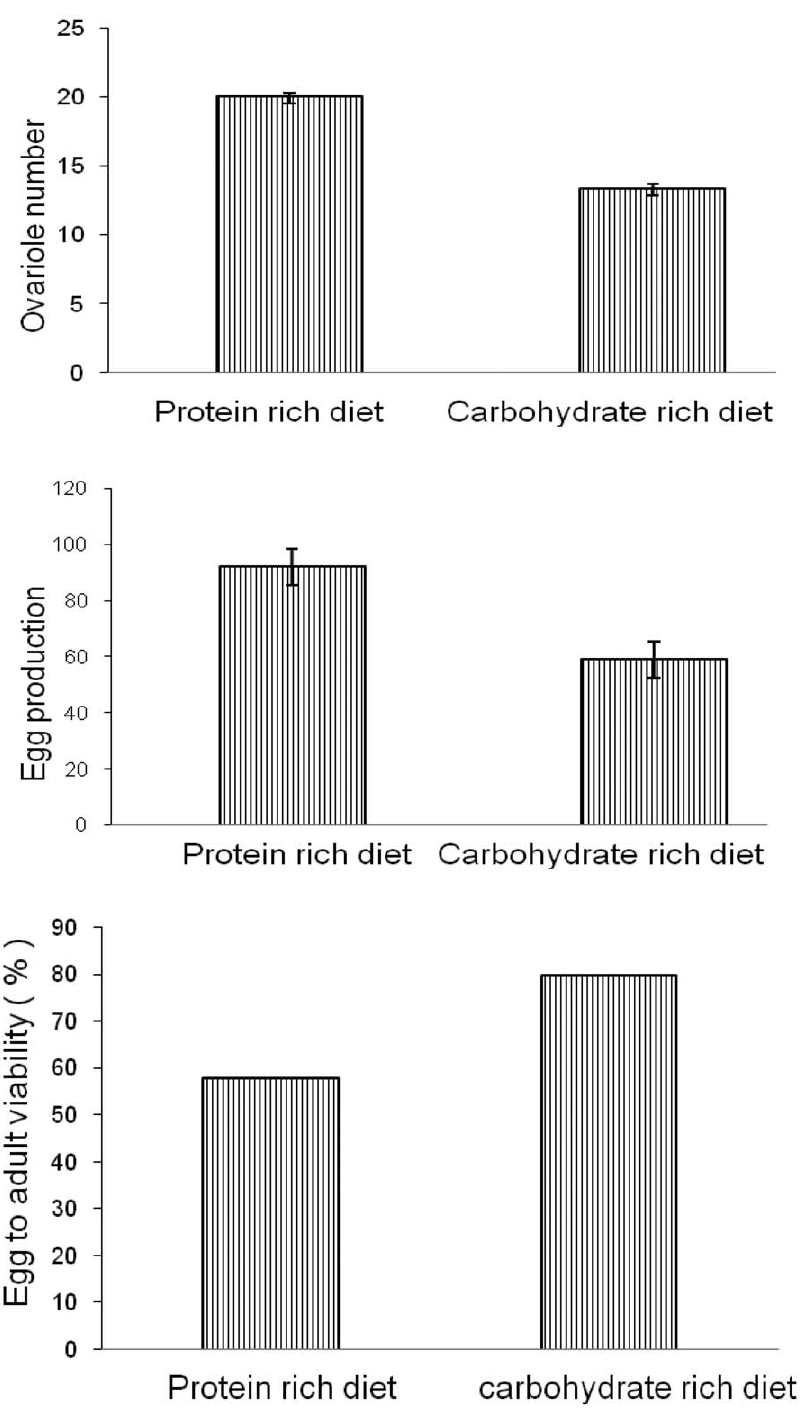
Figure 5. Ovariole number, egg production and egg to adult viability of flies developing on protein rich diet and carbohydrate rich diet. Bar represents Mean ± SE.